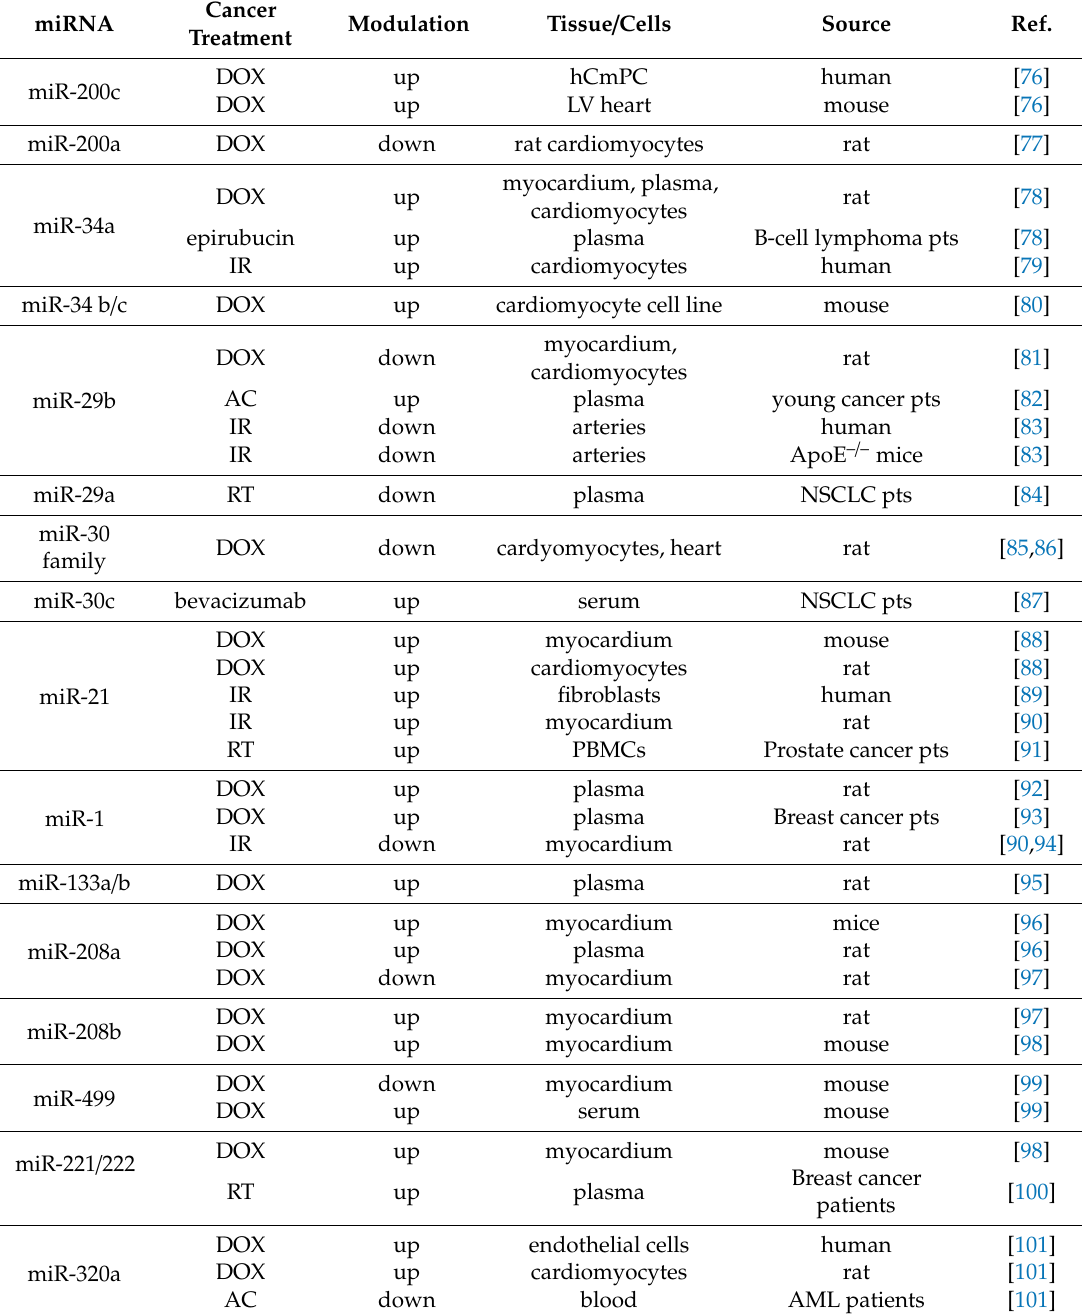
AC down blood AML patients